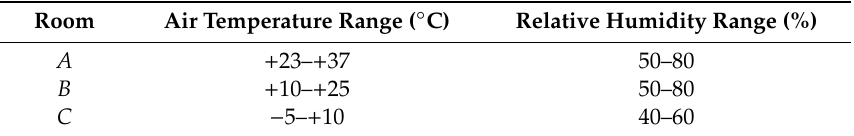
Table 2. Di ff erent temperature and relative humidity ranges that can be provided by the di ff erent Body and Mind (A, B and